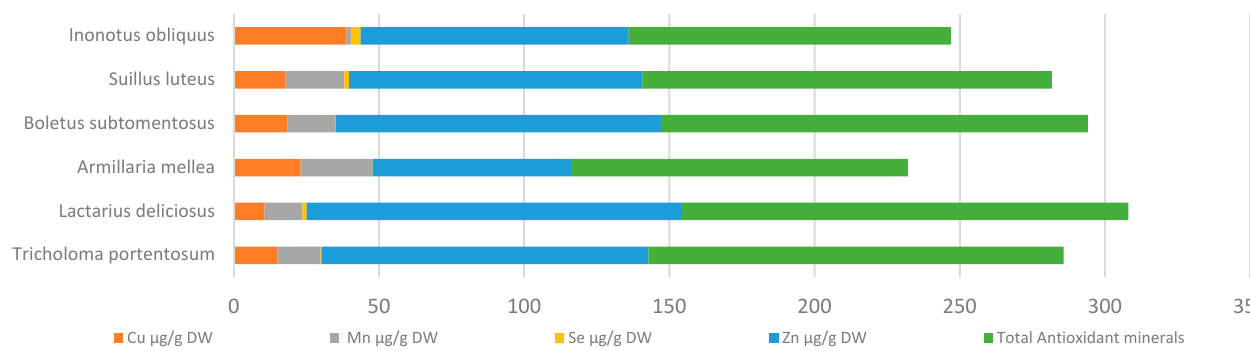
Figure 5. Antioxidant minerals comparison from different species [44].